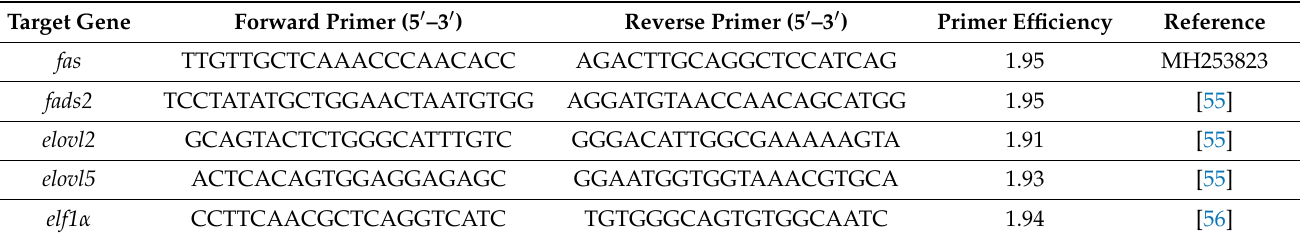
Table 4. Primers used in real-time quantitative